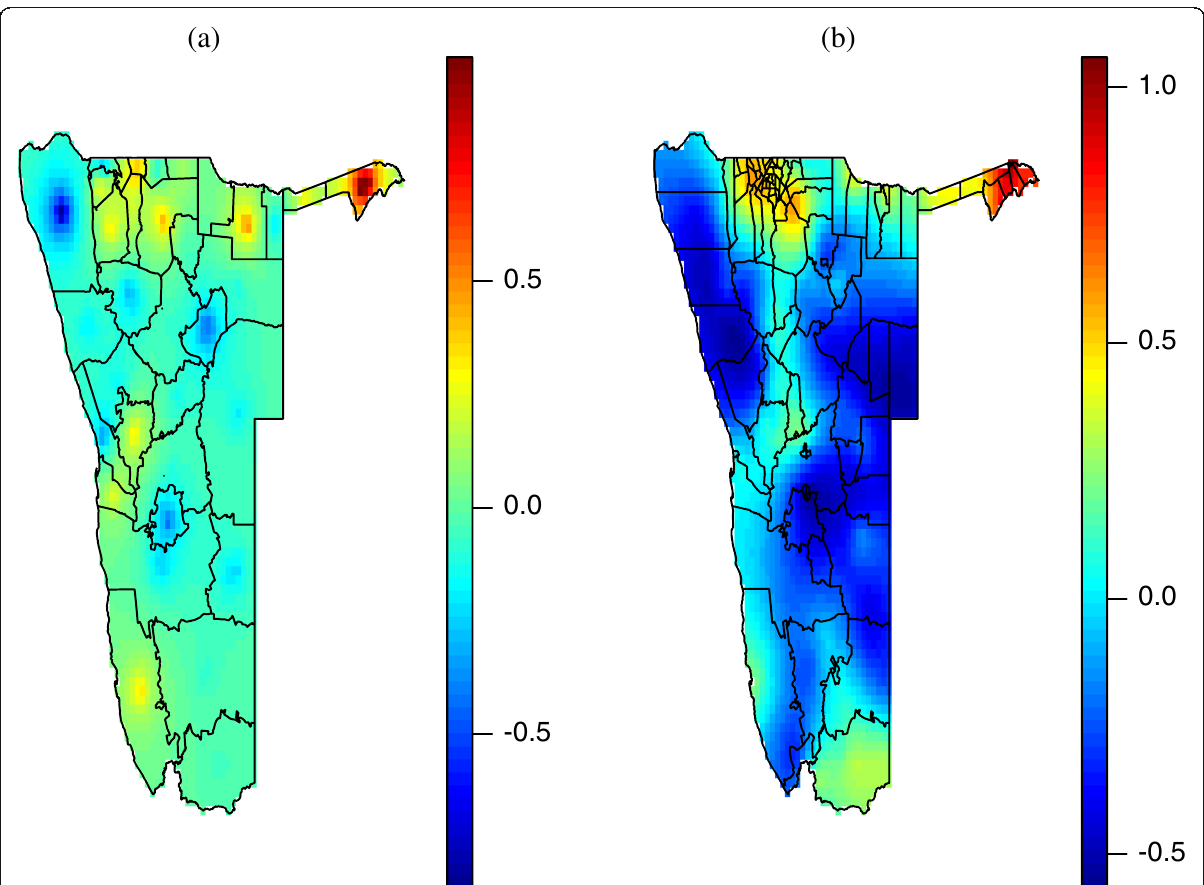
Fig. 6 Posterior means of random effects from univariate models: ( a ) Spatial random effects (NHSS data); ( b ) spatial random effects (NDHS